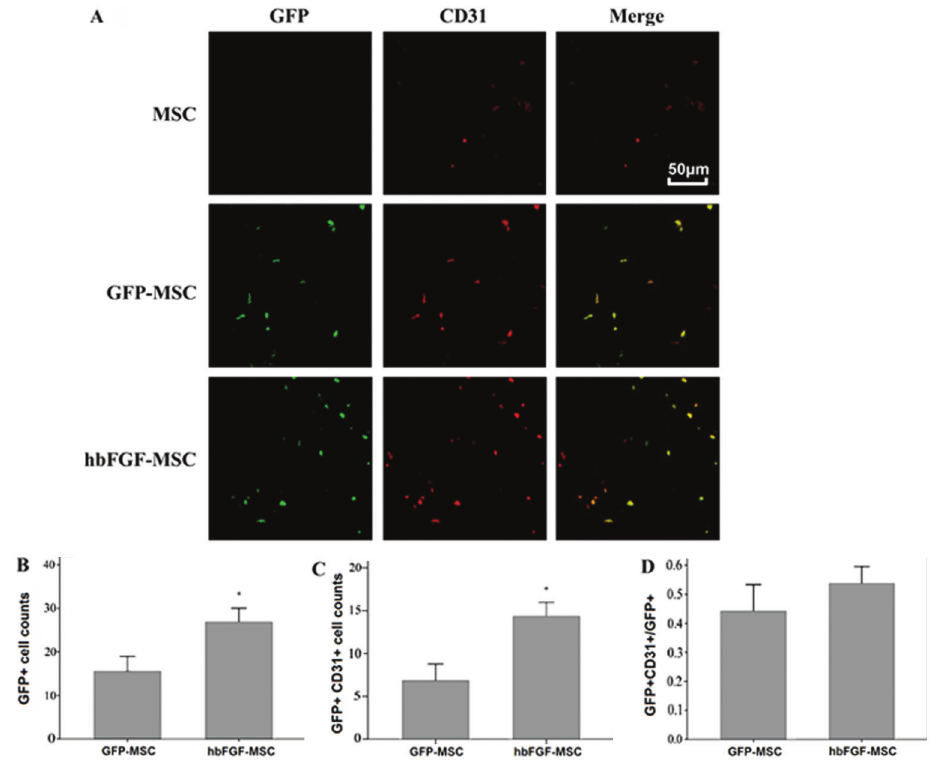
Figure 3. Survival and differentiation of transplanted mesenchymal stem cells (MSCs) in an in vivo hind limb ischemia model. A , Representative images of green fluorescent protein (GFP) (left panels, green) and CD31 (middle panels, red) was determined by immunofluorescence analysis of the gastrocnemius muscle from the MSC, human basic fibroblast growth factor (hbFGF)-MSC, and GFP-MSC groups. Merged images (right panels) identified GFP++CD31++ cells as yellow fluorescence. B , MSC survival was determined by counting the number of GFP++ cells in the hbFGF-MSC and GFP-MSCs groups (n=6/group). C , MSC differentiation was determined by counting the number of GFP++CD31++ cells in the hbFGF-MSC and GFP-MSC groups (n=6/group). D , The ratio of GFP++CD31++ cells to GFP++ cells represents the relative differentiation rate in the hbFGF-MSC and GFP-MSC groups (n=6/group). *P , 0.05, compared to the GFP-MSC group (independent-sample t